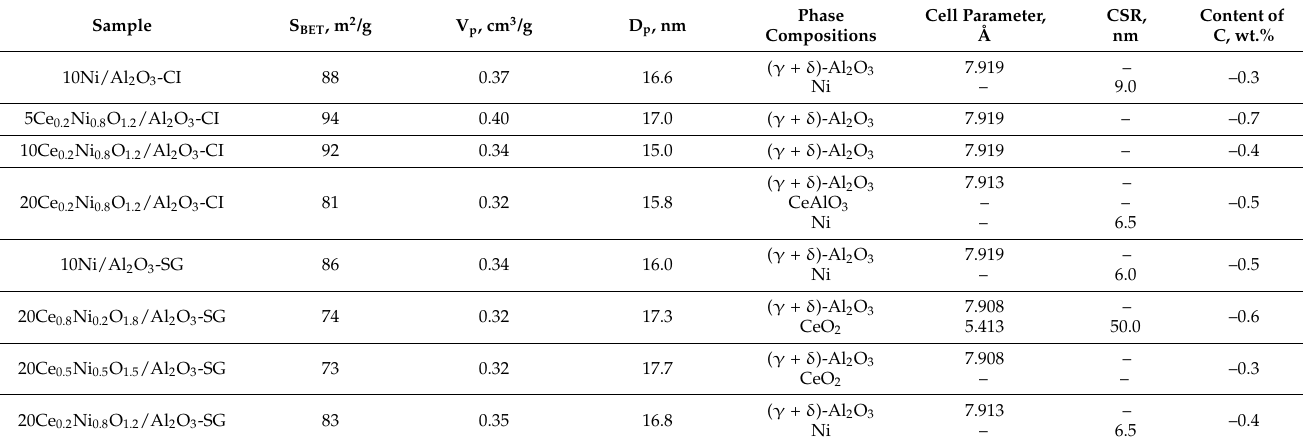
Table 3. Characteristics of the Ce 1 − x Ni x O 2 − x /Al 2 O 3 catalysts after reaction